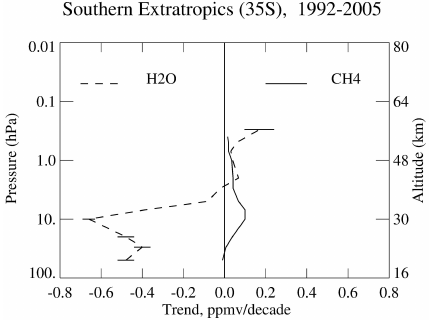
Figure 12. As in Fig. 11, but for 35 ◦ latitude in the Northern Hemi-